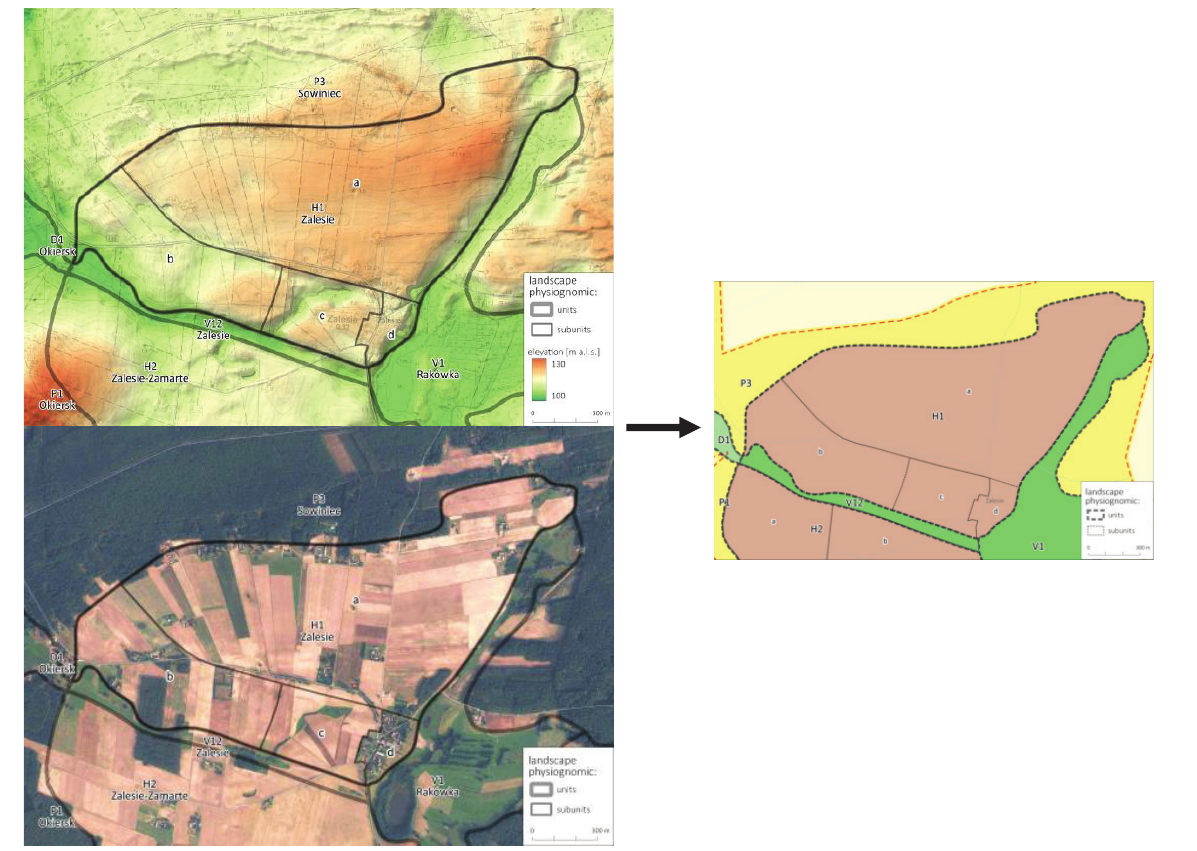
Figure 7. The subdivision of selected LPUs based on the relief and arrangement of land cover characteristics (orthophoto map).